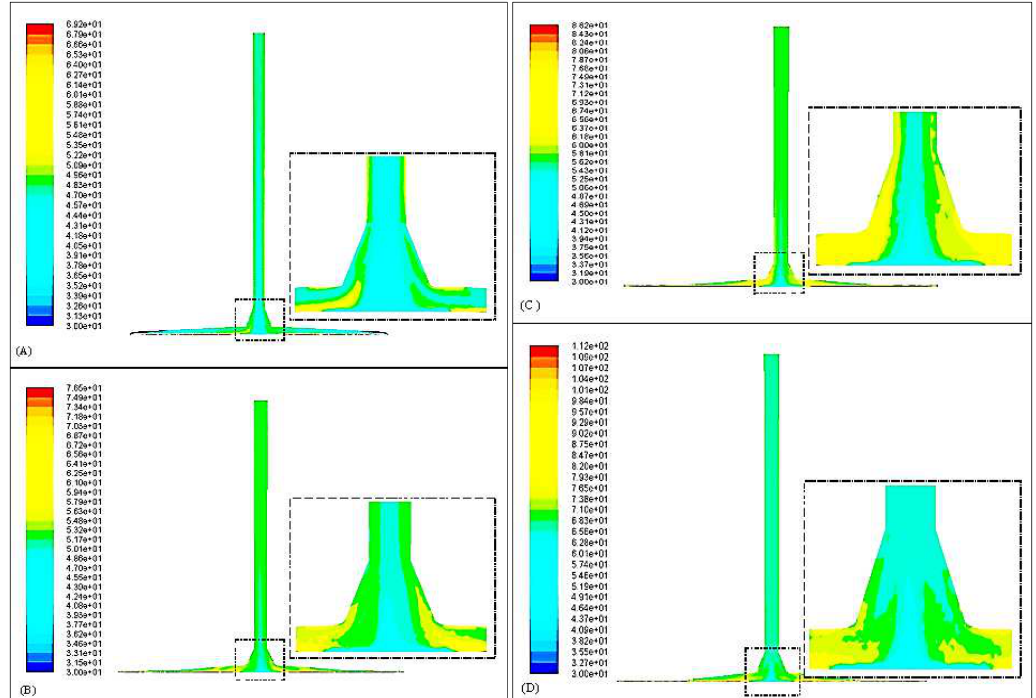
Fig. 14. Contours of static air temperature(c°) (A)without reduction area.(B)at h1=3.8cm.( C)at h2=2.6cm. (D) at